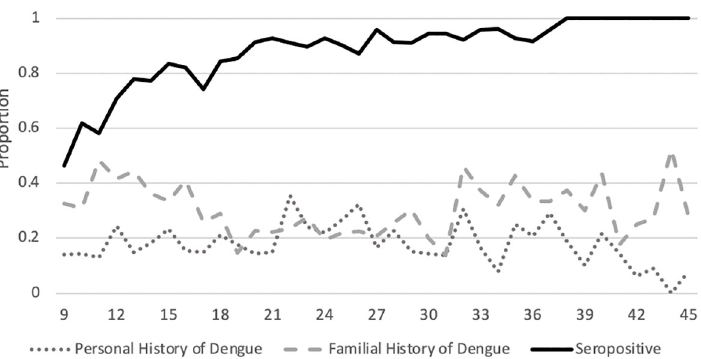
Fig 3. Proportions of participants aged 9–45 years with dengue seropositivity by hemagglutination inhibition assay (black), personal history of dengue (gray dots) and family history of dengue (gray dashed lines) by age.